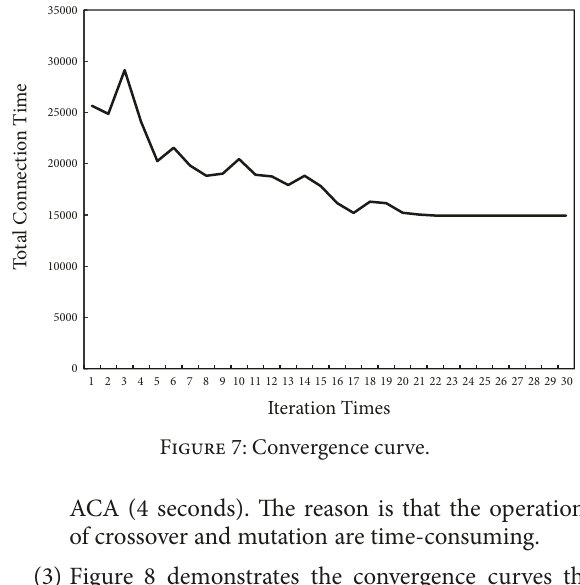
Figure 7: Convergence curve.